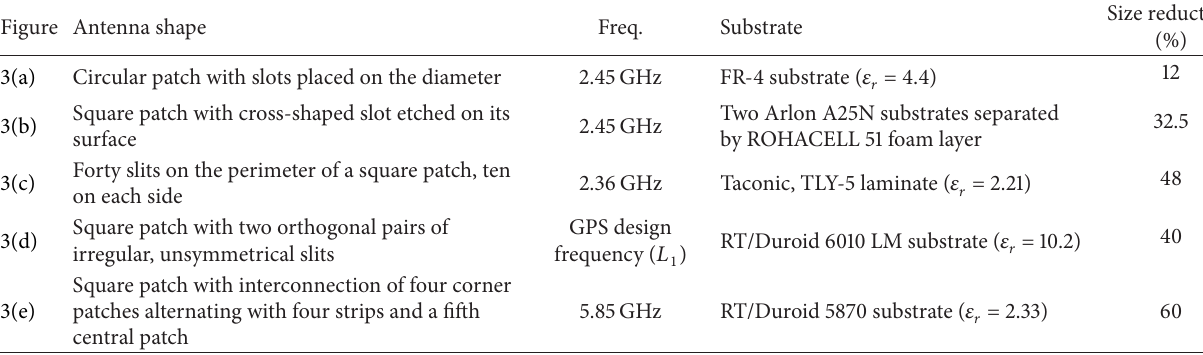
Table 1: Various antenna shapes and size reduction.